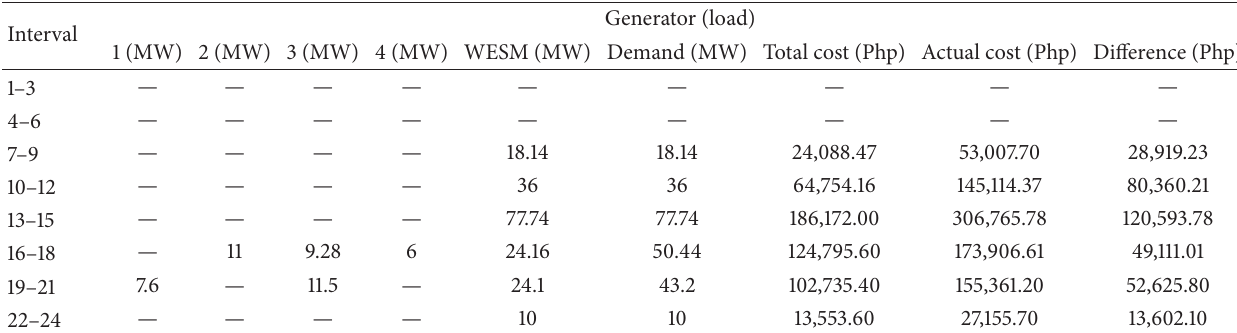
Table 1: Sample of 24-hour dispatch schedule.